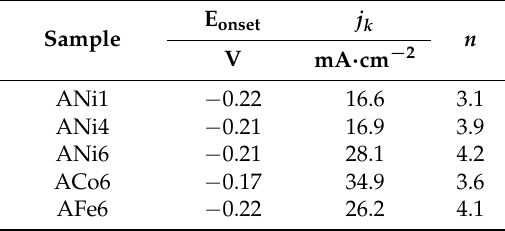
Table 3. Parameters obtained from the analysis of LSV curves (values of n refer to K-L fitting for data at − 0.8